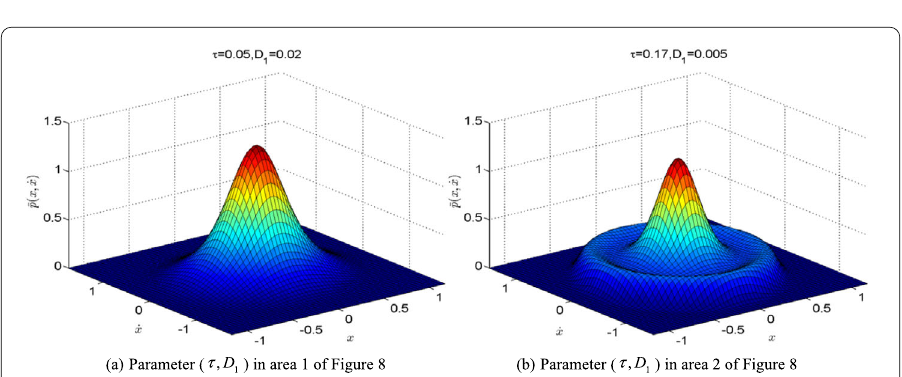
Figure 10 Joint PDFs for ¯ p ( x , ˙ x ) under additive noise excitation (taking τ and D 1 as unfolding